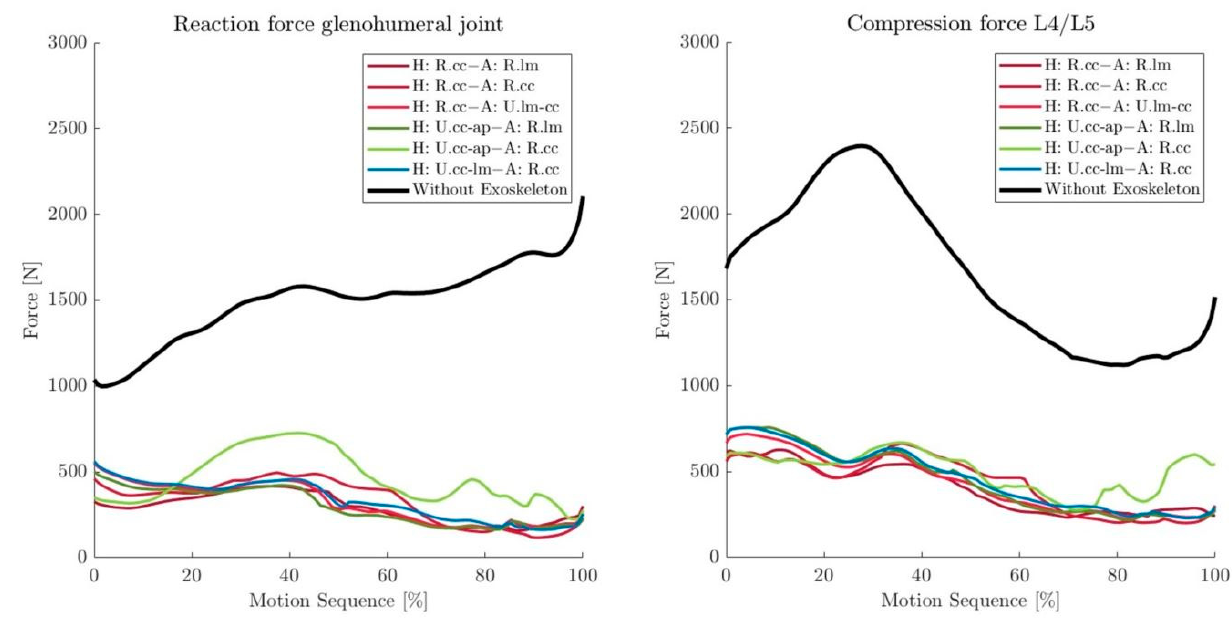
Figure 5. ( Left ): Resultant forces in the glenohumeral joints (averaged between left and right of one